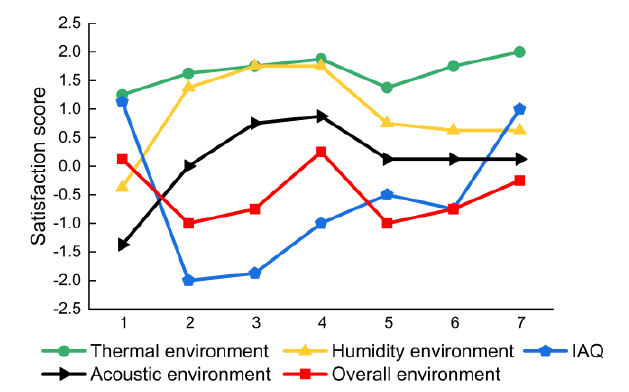
Figure 9. Comparison between single and overall IEQ satisfaction scores in the seven subjective surveys.